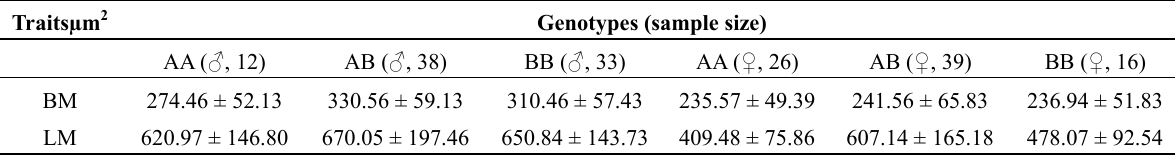
Table 5. Cross-sectional areas of muscle fibers. BM, breast muscle; LM, leg muscle. ♂ , male population; ♀ , female population.